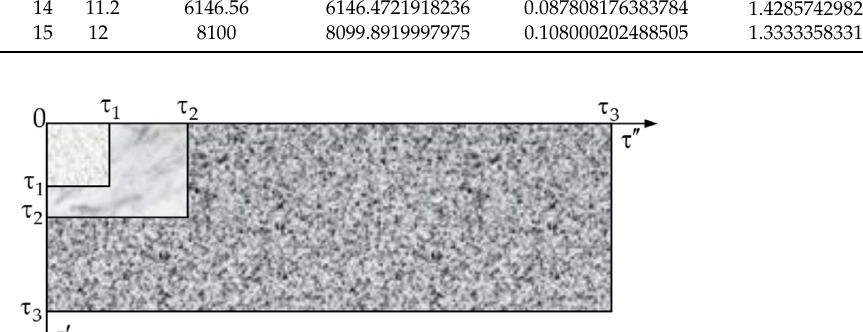
Figure 15. Schematic representation of set of integration regions in the points τ = τ 1 , τ = τ 2 , τ = τ 3 for g ( τ ) = τ 2 .